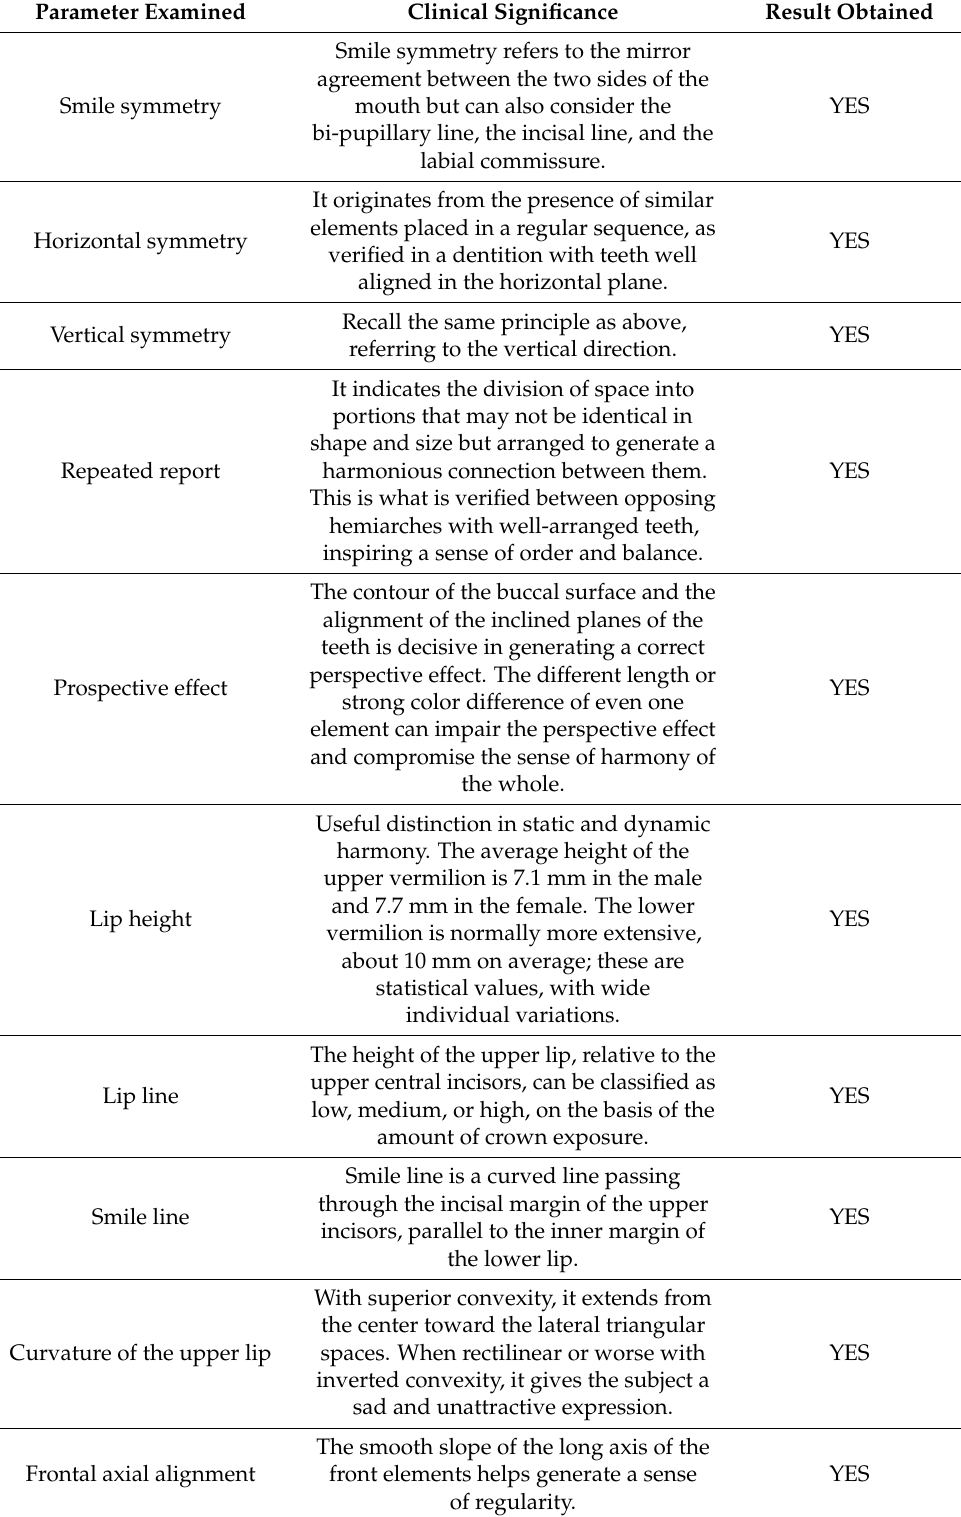
Table 2. Smile aesthetic